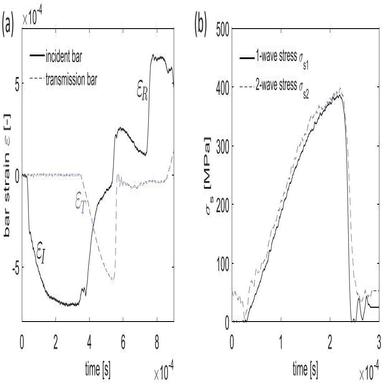
Bar strain wave group of an SHPB UNC test (a) and dynamic stress equilibrium check (b).